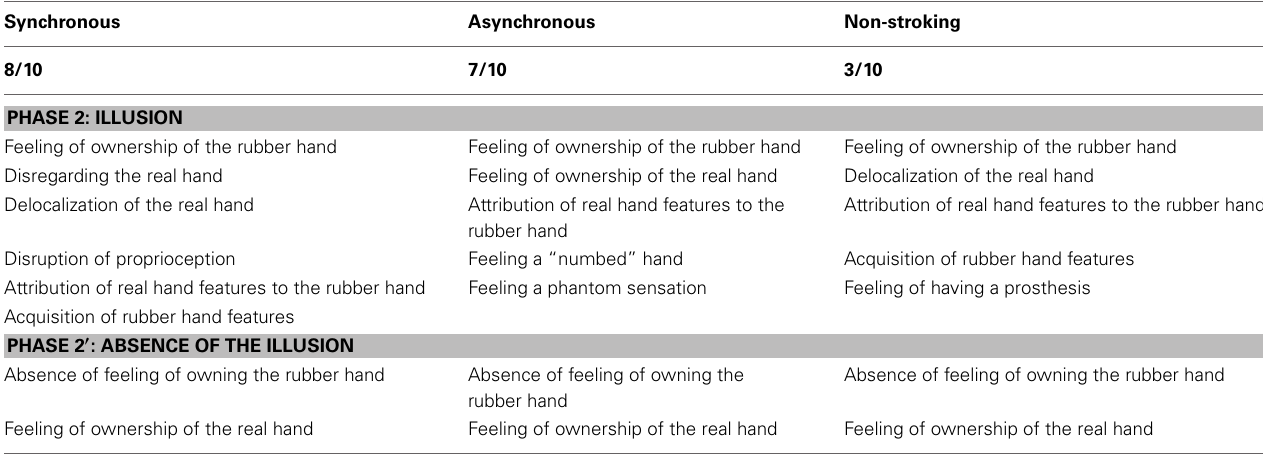
Table 1 | Summary of the experiential categories corresponding to Phases 2 and 2’ in the three stroking conditions.